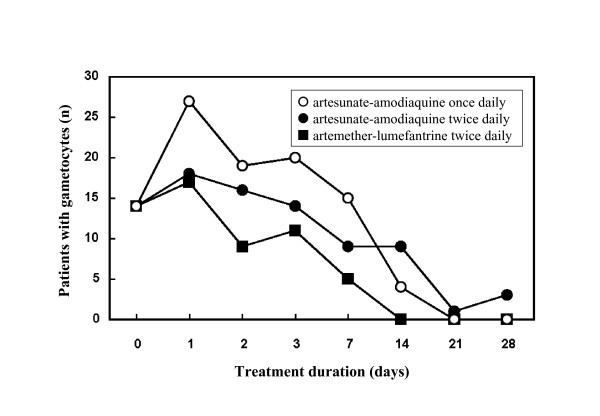
Gametocyte clearance. Data are presented as the number of patients with gametocytes.